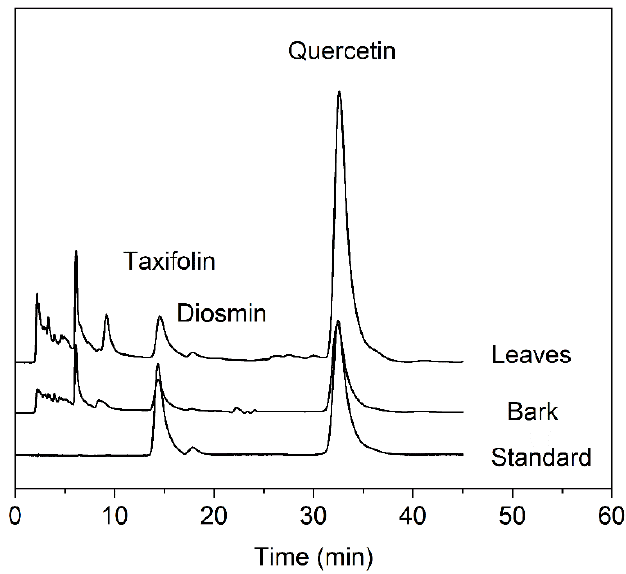
Figure 8. The chromatography analysis of mixture standard, A. nephrolepis leaves and bark (375 nm).